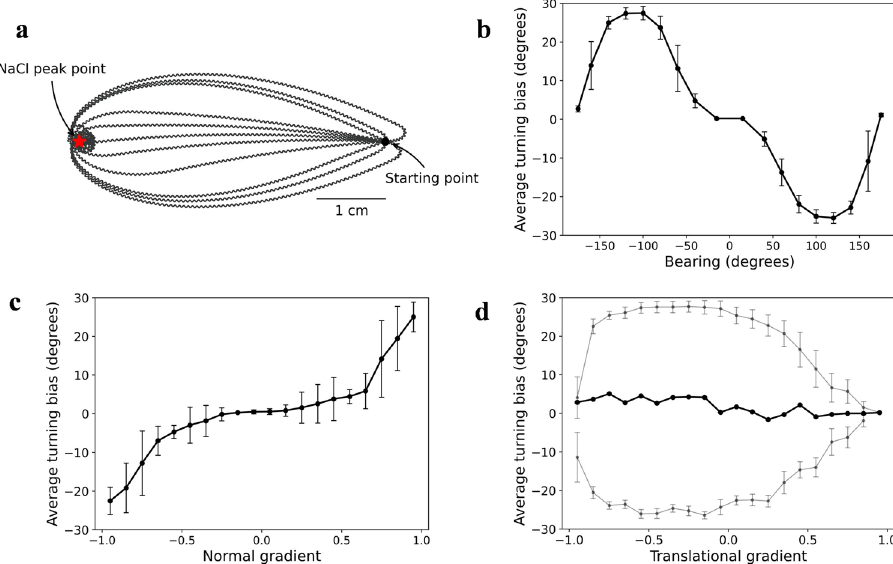
Figure 2. Behavioral analysis of klinotaxis in the model elegans . ( a ) Multiplication of the locomotion tracks with different initial orientations. ( b ) Average turning bias vs. bearing. ( c ) Average turning bias vs. normal gradient. ( d ) Average turning bias vs. translational gradient. The gray dots represent the average positive and negative turning biases. The error bars represent